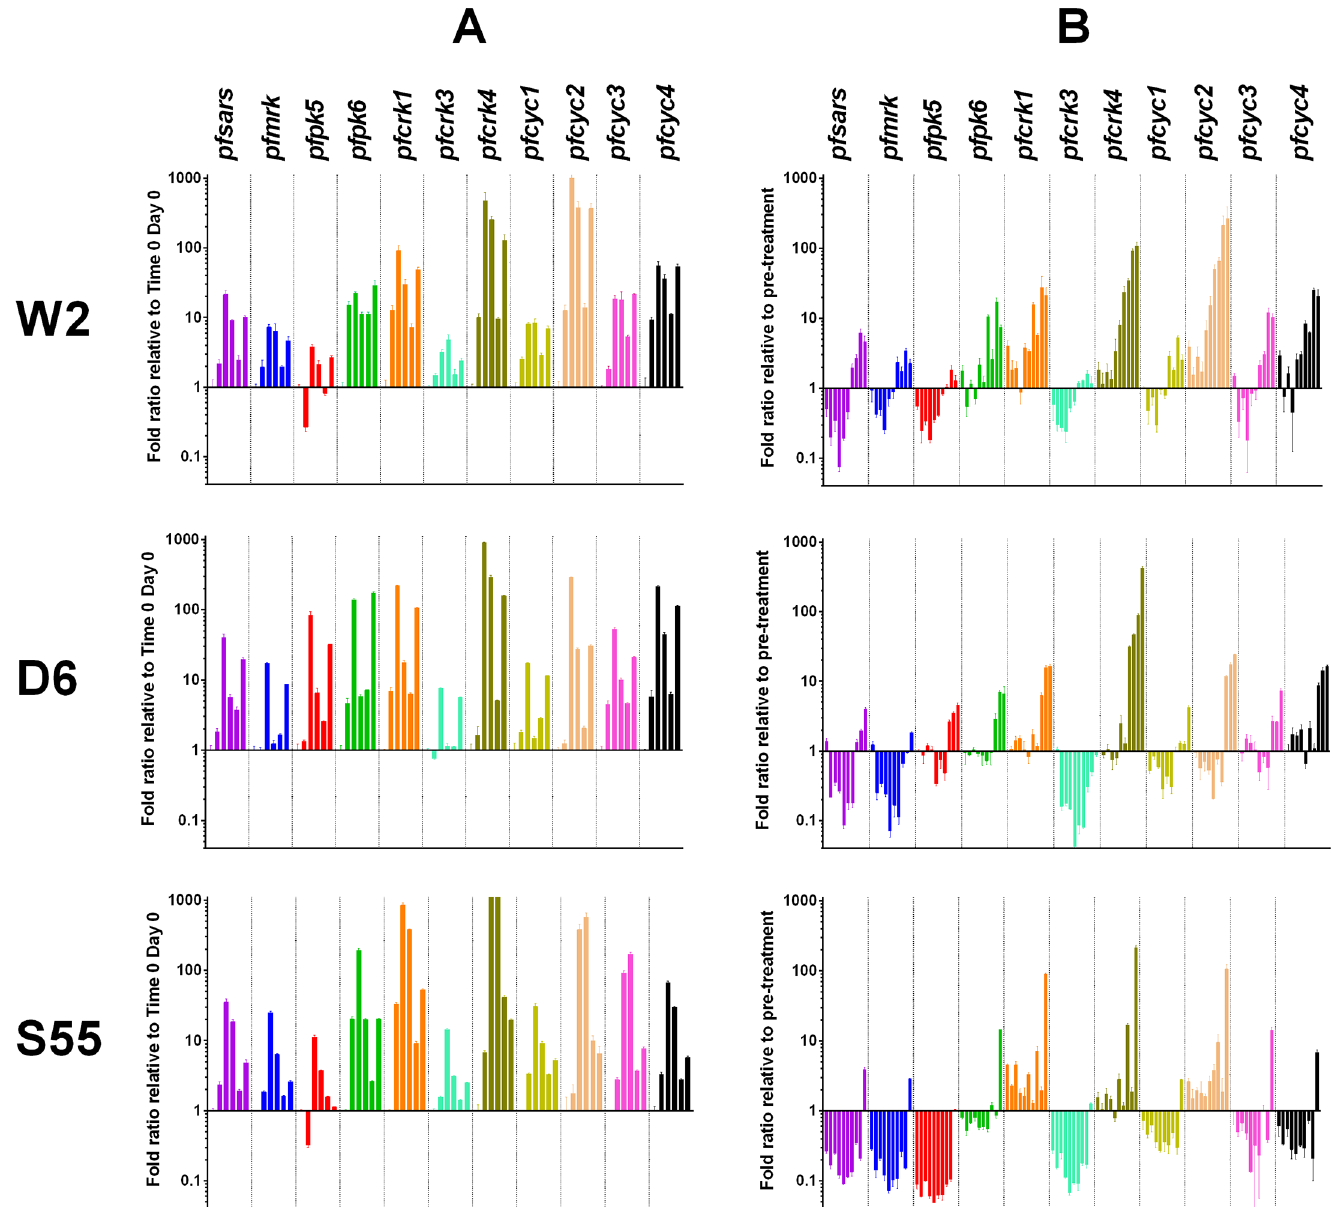
Fig 2. Transcription levels of CDK and cyclins (shown in different colours) in untreated and DHA treated P . falciparum W2, D6 and S55 parasites. Panel A: untreated parasites. Transcription levels of each gene at 12, 24, 36, 48 and 60 h are grouped from left to right and are expressed as fold ratio relative to time 0. Panel B: DHA treated parasites. Transcription levels of each gene between day 1 and day 10 are grouped from left to right and are expressed as fold ratio relative to pre-treatment (time 0 h of untreated parasites on Day 0). Error bars represent standard